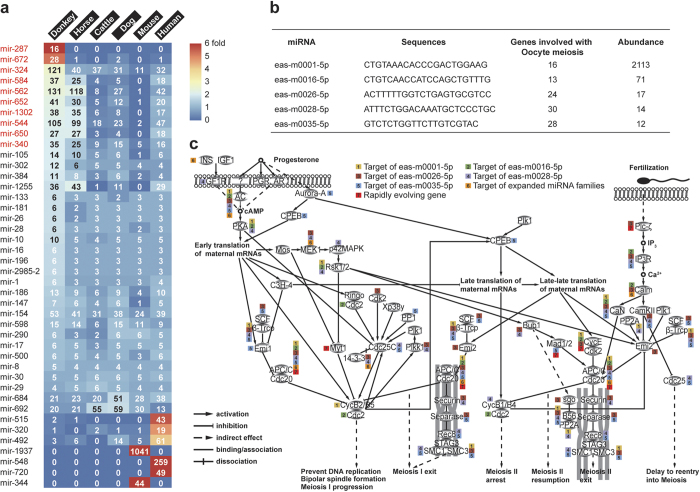
Novel miRNAs, expanded miRNA families and rapidly evolving genes in donkey, which are associated with the meiosis pathway.(a) Expanded miRNA families (red) in the donkey genome. (b) Five novel miRNAs targeting meiosis in the donkey genome identified by RNA-seq. (c) The donkey meiosis pathway. Small boxes indicate that the gene is regulated by novel miRNAs, expanded miRNA families or rapidly evolving genes.